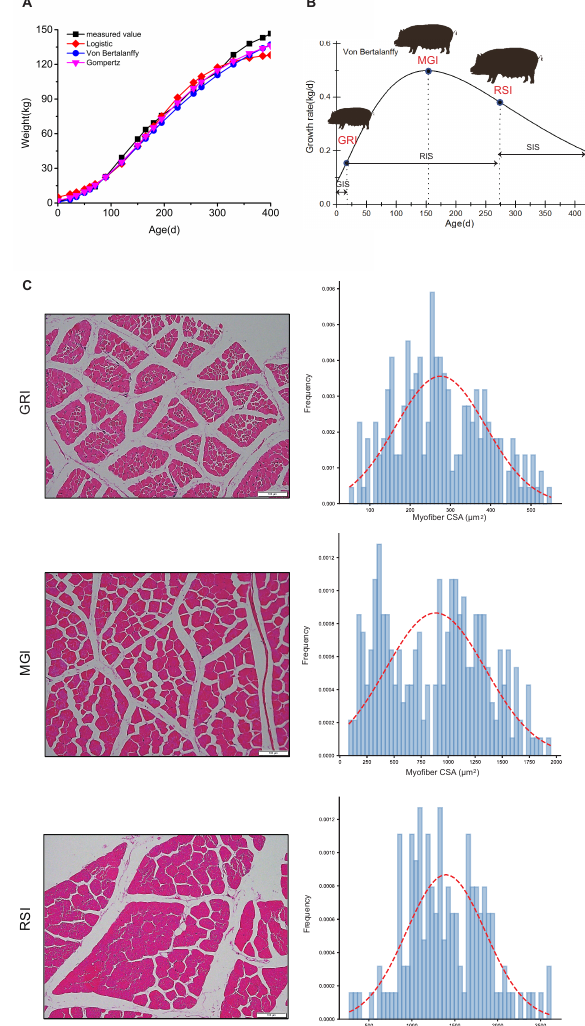
Figure 1. Growth curves and immunohistochemical staining of Qingyu pigs. ( A ) Sigmoidal curve of body weight fitted by Logistic, Von Bertalanffy and Gompertz curve models, respectively. ( B ) Daily weight gain of Qingyu pigs fitted by Von Bertalanffy curve model. ( C ) Hematoxylin and eosin (HE) staining of longissimus dorsi muscle myofiber cross section aera (CSA) (left, bar = 100 µ m) at GRI, MGI and RSI, respectively. Myofiber areas were measured and their distribution was calculated as the frequency of the number of myofibers in a designated area divided by the total number of myofibers assessed (right). Abbreviations: GIS, gradually increasing stage; RIS, rapidly increasing stage; SIS, slowly increasing stage; MGI, the inflection point with the maximum growth rate; GRI, the inflection of the gradually increasing stage to the rapidly increasing stage; RSI, the inflection point of the rapidly increasing stage to the slowly increasing